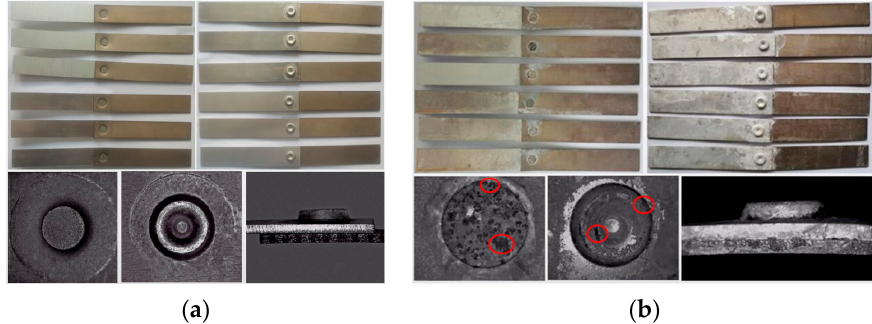
Figure 3. Appearance of the joints at different corrosion times of ( a ) 0 weeks; ( b ) 7 weeks.